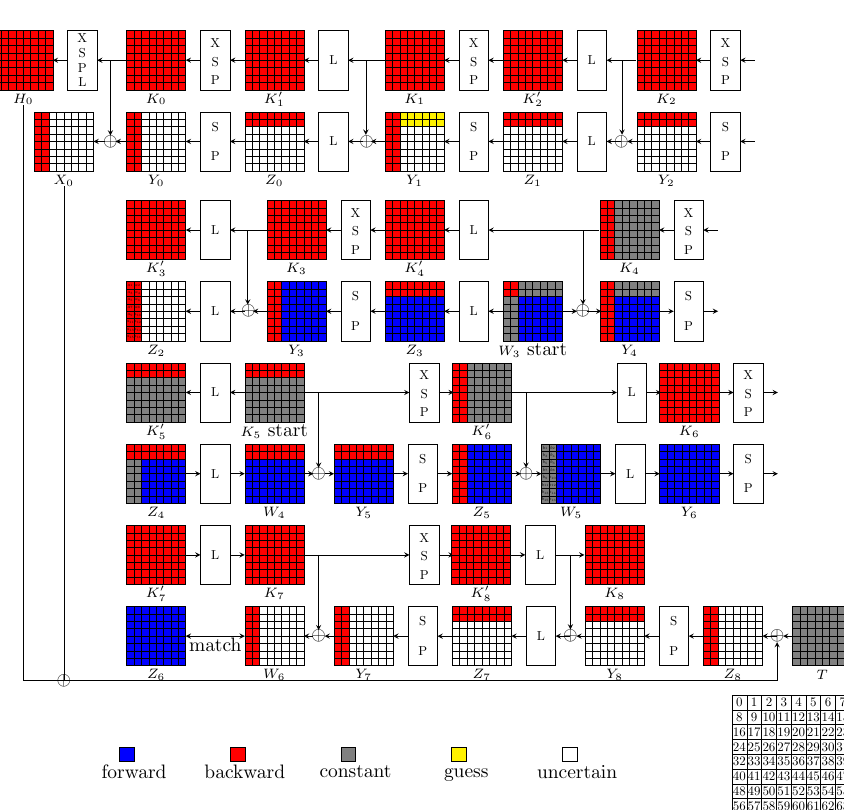
Figure 5: 8.5-round preimage attack on Streebog-512 compression